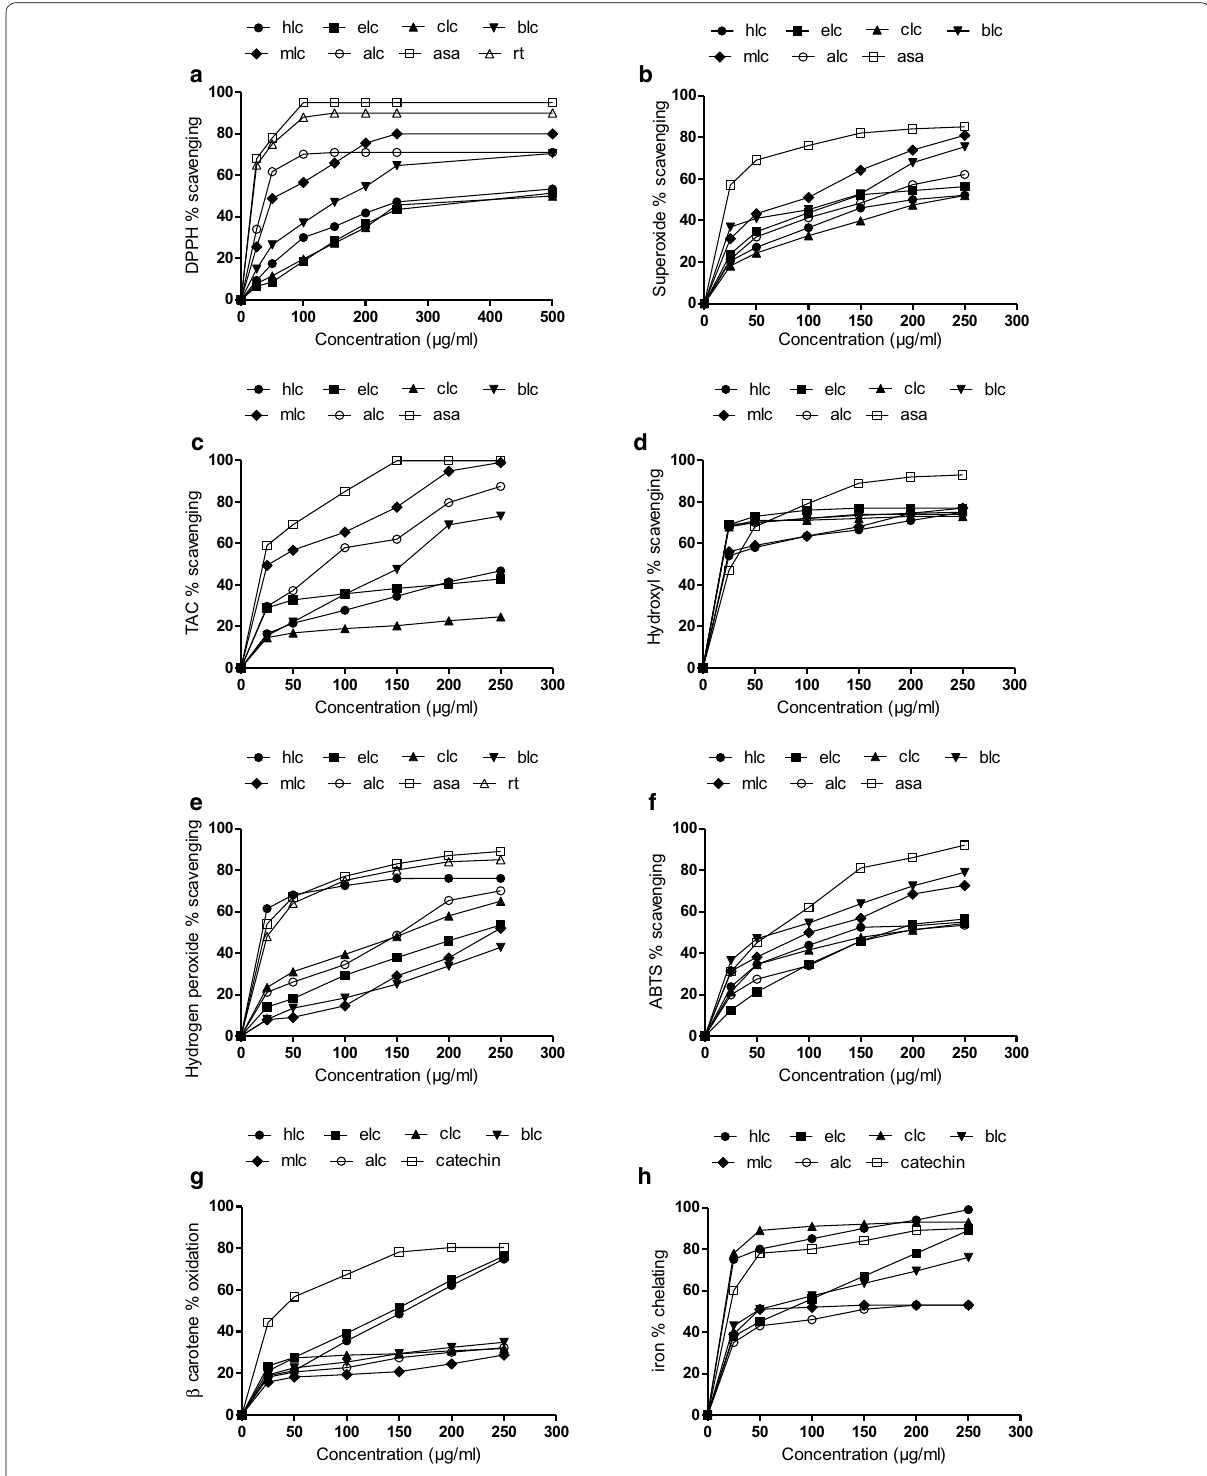
Fig. 1 Scavenging potential of C. opaca leaves. a DPPH radical scavenging activity. b Superoxide inhibition. c Total antioxidant capacity. d hydroxyl percentage inhibition. e Hydrogen peroxide percent inhibition. f ABTS percent inhibition. g β-Carotene percent inhibition. h Chelating ability of various fractions of C. opaca fruit at different concentrations. Each value represents a mean fraction, clc chloroform fraction, blc butanol fraction, mlc methanol extract, alc aqueous fraction, rt rutin, asa ascorbic